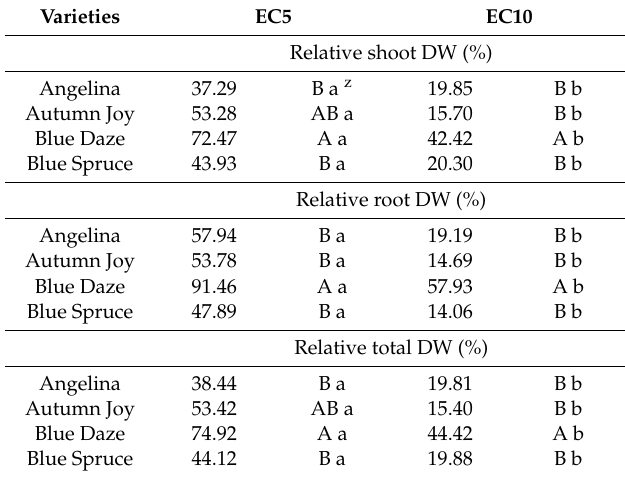
Table 2. Relative means of shoot, root, and total dry weight (DW) of four varieties of perennial ornamentals irrigated with control or saline solutions for eight weeks.